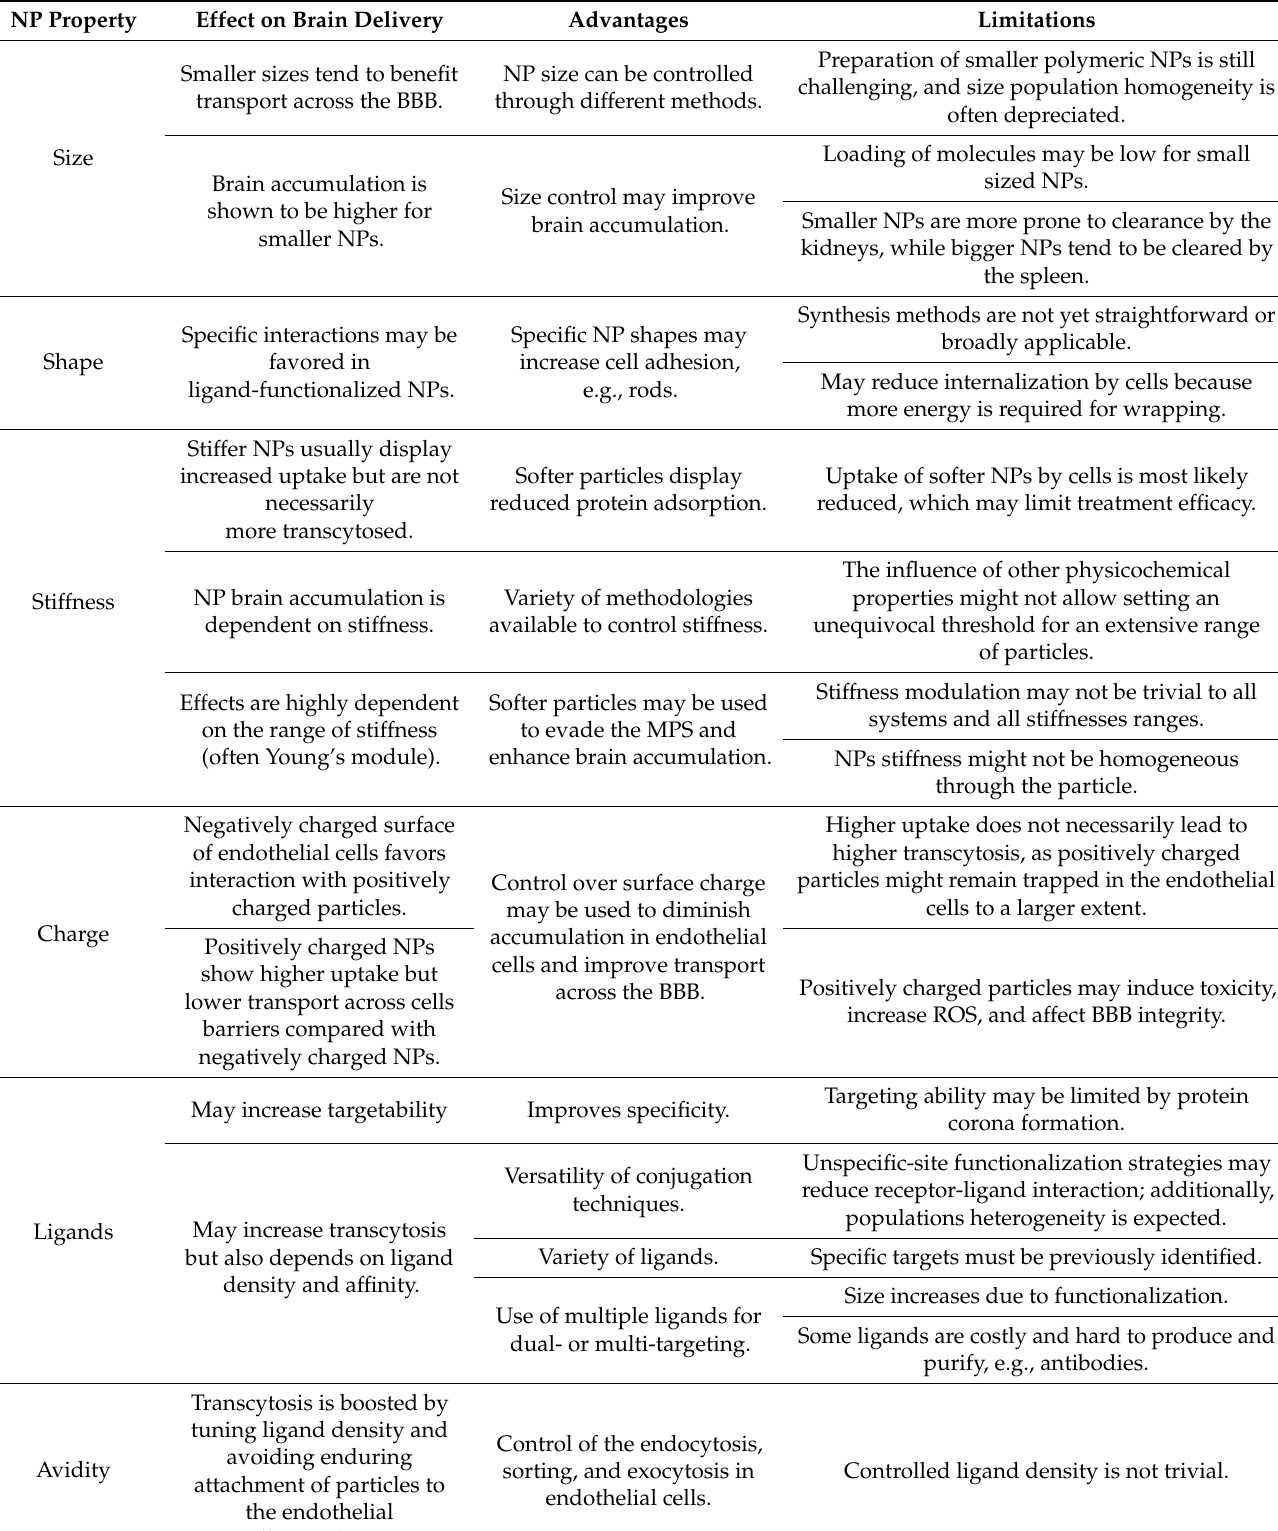
Table 1. Summary of the effects of polymeric NPs properties in brain delivery and NPs properties advantages and limitations in